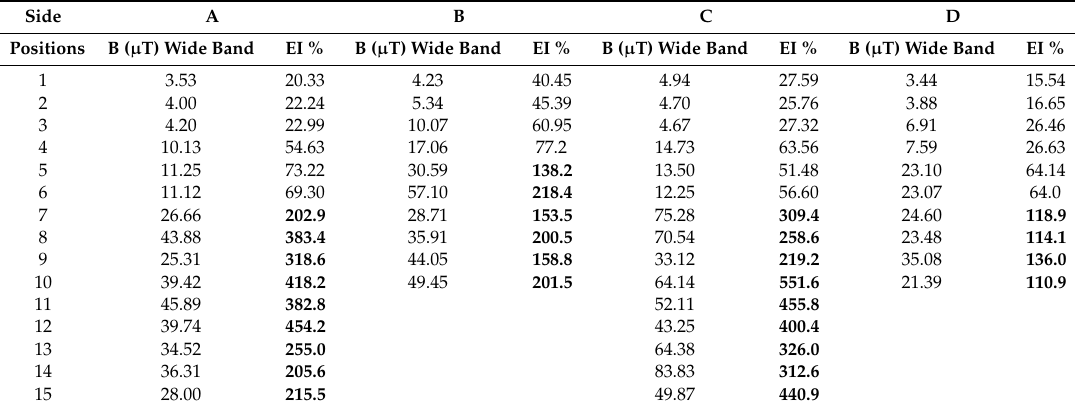
Table 3. B-field and EIs according to the measurement grid for the power unit master, HPCS 1. Side A B C D